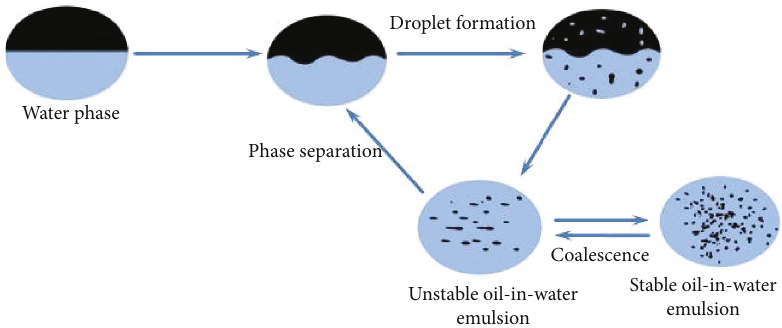
Figure 8: Steps of emulsion, formation, and separation [28].